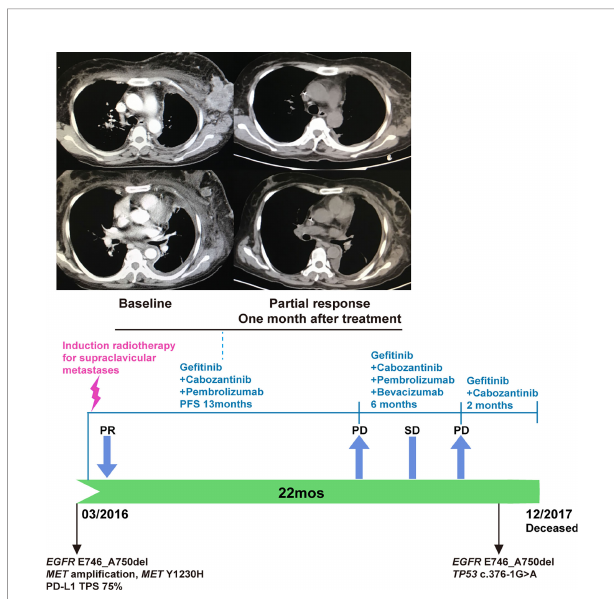
FIGURE 3 | The combination of ge fi tinib, cabozantinib, and pembrolizumab for PD-L1-positive, EGFR -mutated, MET -ampli fi ed, MET Y1230H NSCLC. A partial response was observed one month after the initiation of this triplet regime (upper panel). Bevacizumab was added when the patient developed new metastases in April 2017. Both bevacizumab and pembrolizumab were stopped in October 2017 due to acute patient deterioration (lower